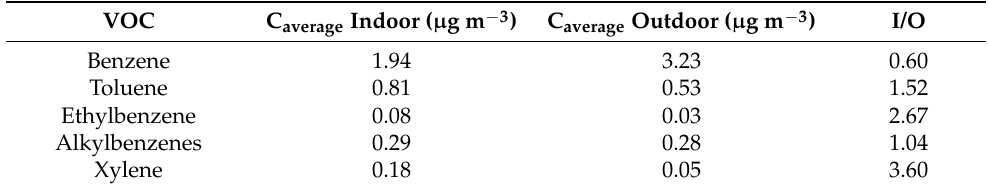
Figure 3. Benzene, Toluene, Ethylbenzene, Xylene, and Alkylbenzenes indoor mean concentration values over the entire monitoring period in the different school areas investigated. B1 indicates the male bathroom site, B2 the female bathroom site, 4B the classroom 4B, 4E classroom 4E, and O4E the external balcony outside classroom 4E. Table 3. Benzene, Toluene, Ethylbenzene, Alkylbenzenes, and Xylene indoor and outdoor mean concentration values.